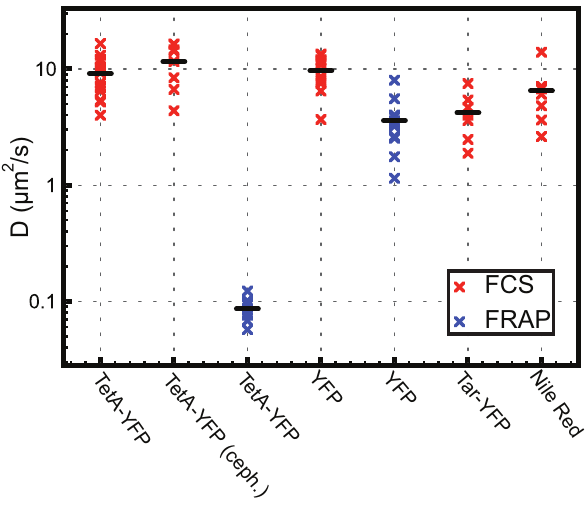
Figure 2. Diffusion constants. Diffusion constants measured with FCS (red symbols) and FRAP (blue symbols), from left to right: TetA-YFP measured by FCS in E. coli strain DGC103 (15 measurements, D TetA - YFP =9.1 6 3.4 m m 2 /s; all values presented are mean 6 SD); FCS TetA-YFP measured by FCS in cephalexin-treated DGC103 (8 measure- ments, D TetA - YFPfilamented